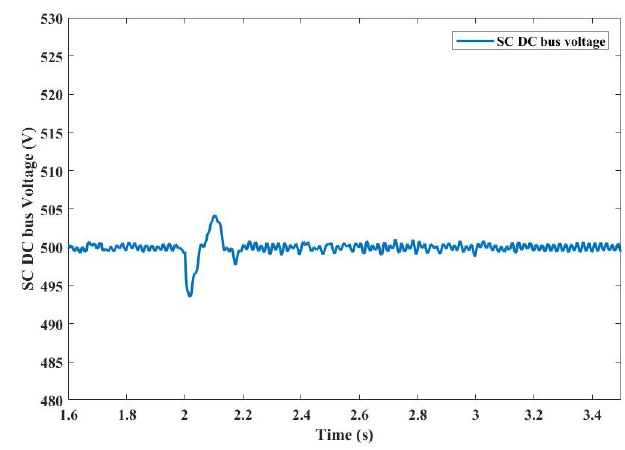
Figure 13. DC bus voltage at SC for under-frequency event.